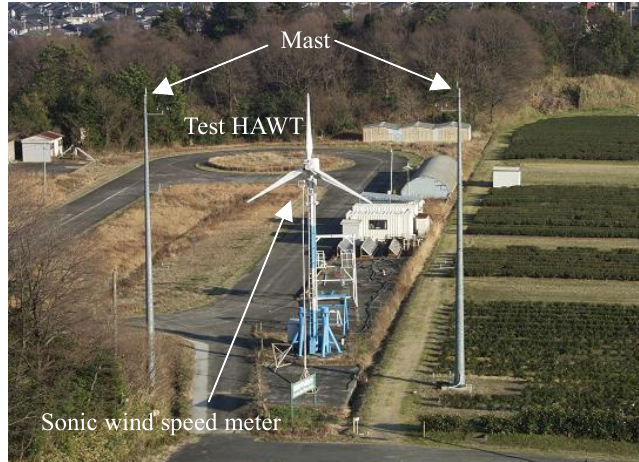
Figure 1. Test wind